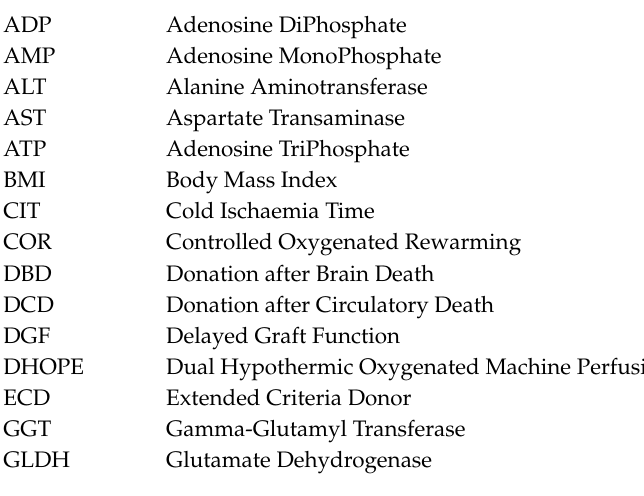
Table 13. MP studies that reported tissue ATP in pancreas (2009–2019). Temp / ◦